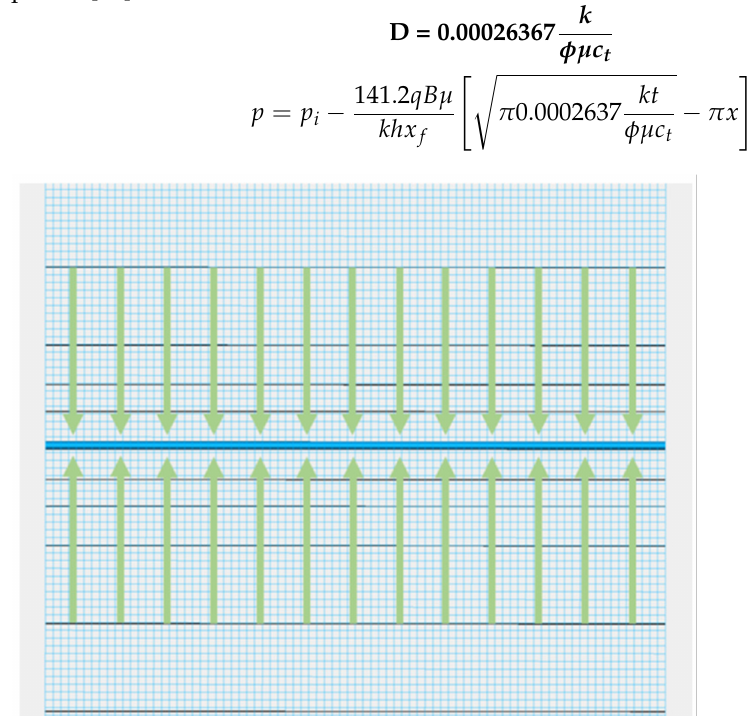
Figure 12. Pressure Iso-line (Conventional Analytical for early time linear flow Model).